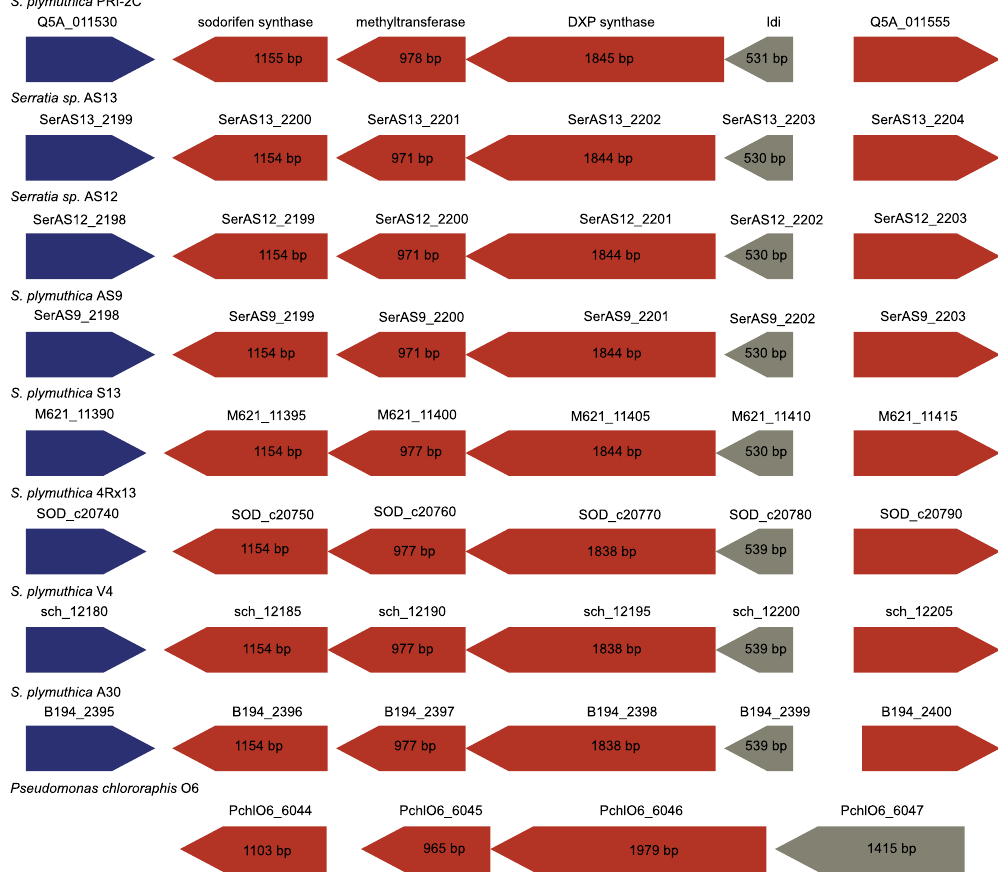
Figure 7. Comparison of the sodorifen cluster within other bacteria. The sodorifen synthase (Q5A_011535) forms a cluster with three additional genes, methyltransferase (Q5A_011540), 1-deoxy-D-xylulose-5-phosphate synthase (Q5A_011545) and isopentenyl-diphosphate delta-isomerase (Q5A_011550), which are positioned in the sense direction within the genome of S. plymuthica PRI-2C. The cluster is bordered by genes that are in antisense orientation. Red indicates biosynthesis genes, blue indicates regulatory genes and grey indicates other